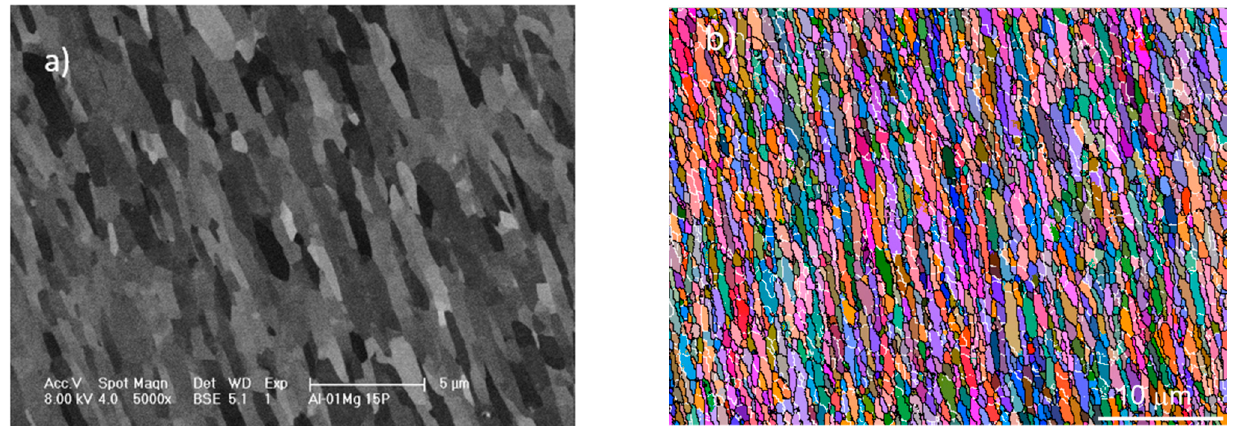
Figure 1. EBS image ( a ) and EBSD map ( b ), showing the UFG structure of the Al-0.1Mg alloy after 15 passes ECAE processing at room temperature. The extrusion direction (ED) is vertical.